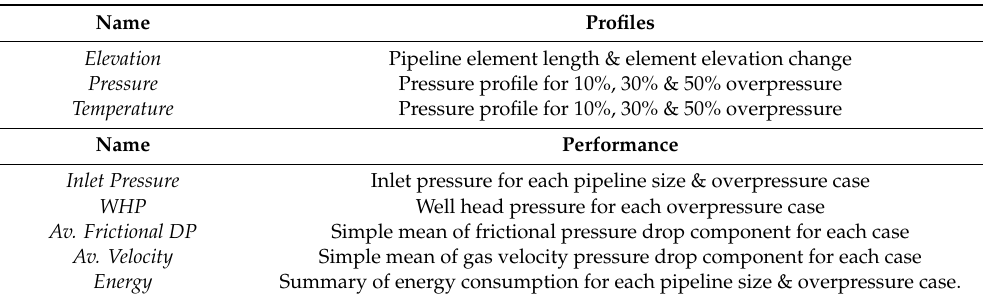
Table 4. Summary of Model Outputs.